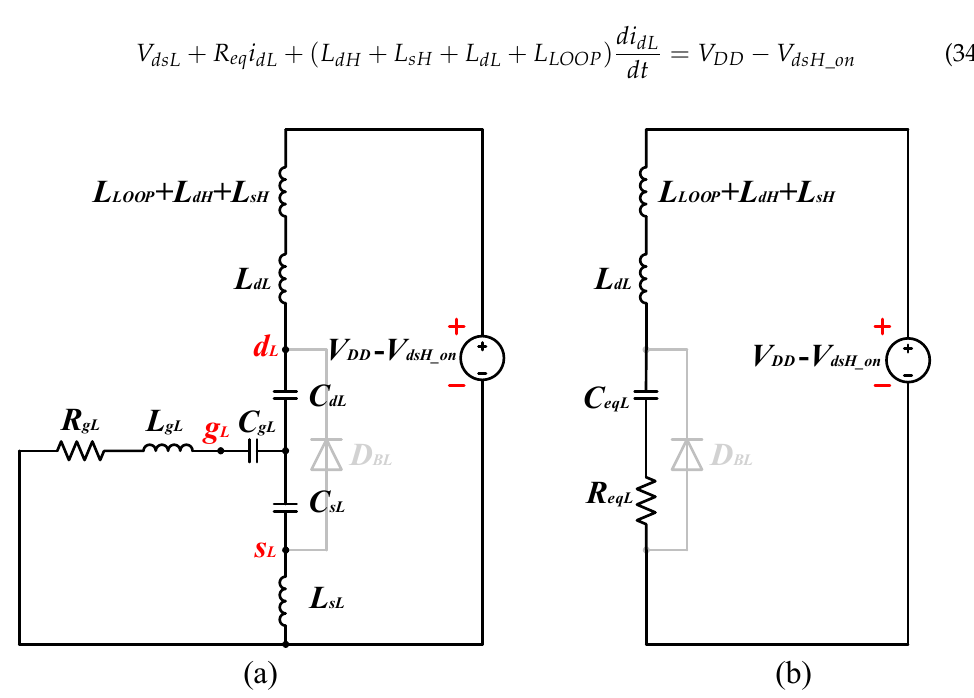
Figure 14. Simplified equivalent circuit for bridge-arm in Stage 4. ( a ) Star connection equivalent circuit; ( b ) Second-order equivalent circuit.